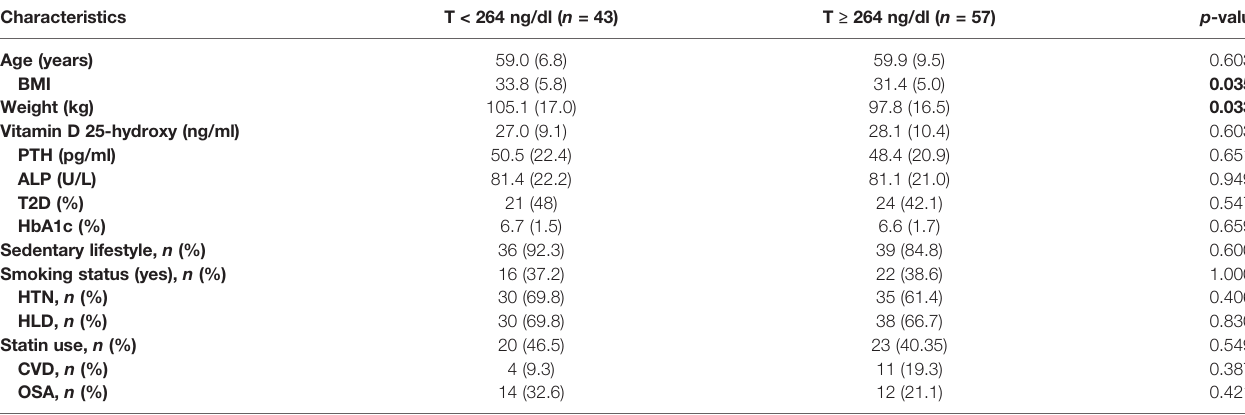
TABLE 1 | Demographic and baseline clinical